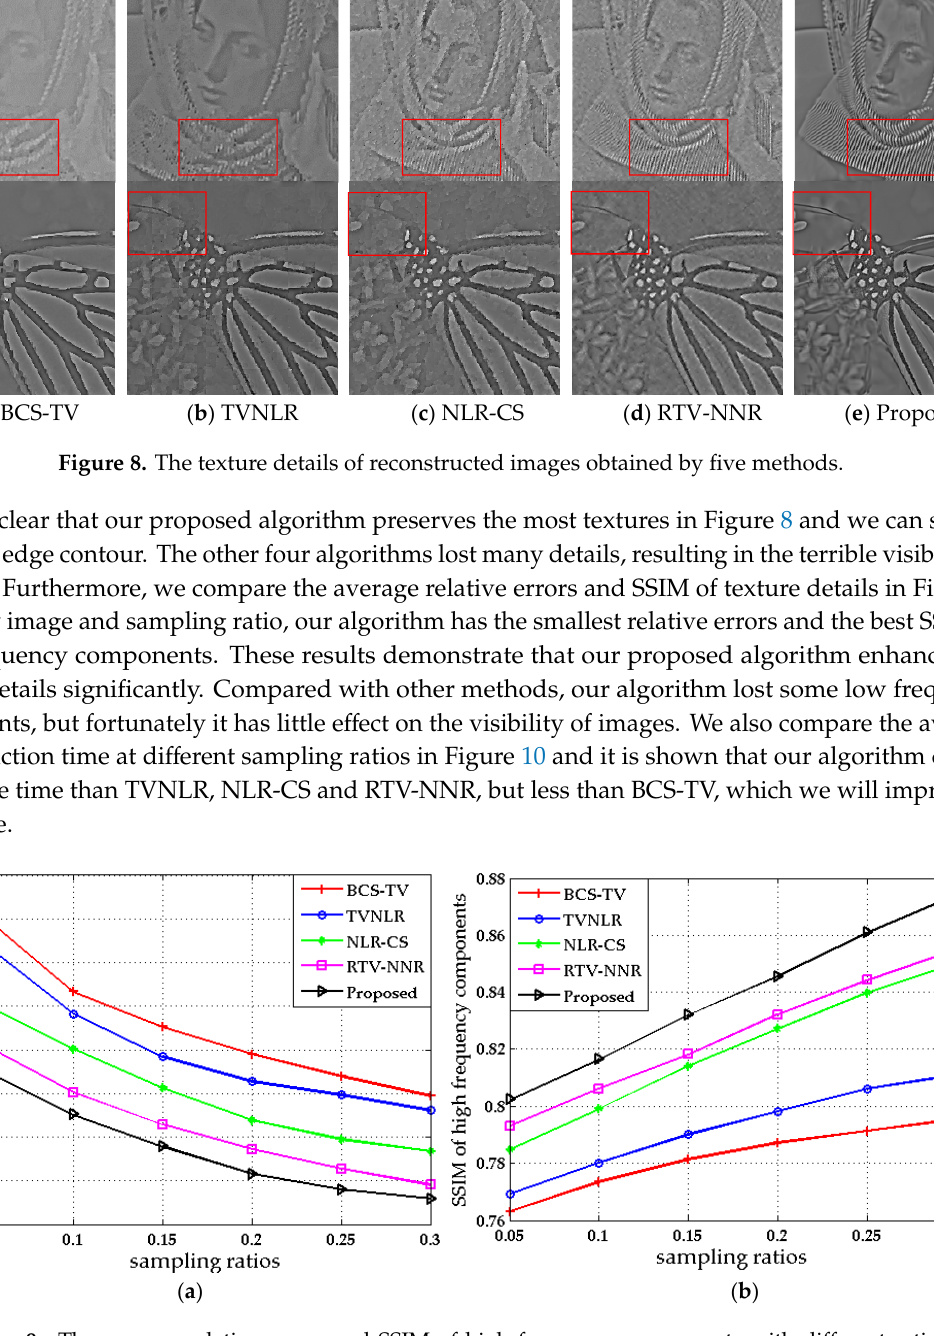
Figure 9. The average relative errors and SSIM of high frequency components with different ratios: ( a ) average relative errors of high frequency components, ( b ) average SSIM of high frequency components.